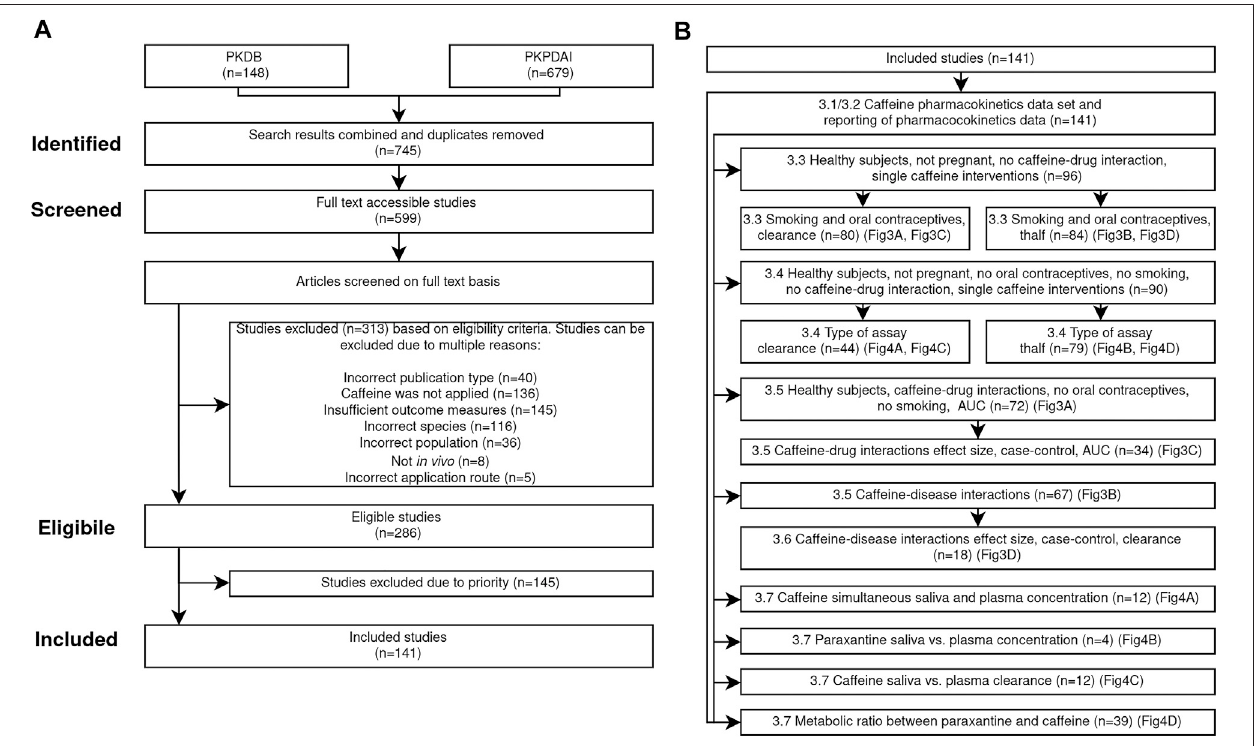
FIGURE 1 | PRISMA fl ow diagram. (A) Overview of search strategy and inclusion/exclusion criteria applied in the systematic analysis of pharmacokinetics of caffeine.Theappliedwork fl owresultedin n (cid:1) 141includedstudies. (B) Subsetsoftheincludedstudieswereusedforthevariousanalyses.Fordetailsseethe Section2 .